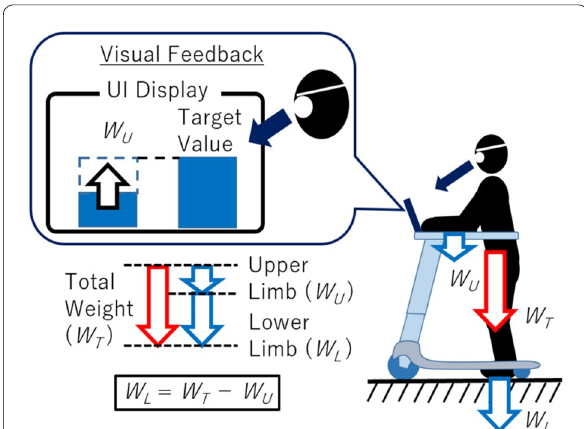
Fig. 3 When W U is applied to the walker, W L is reduced following the relationship between the load applied to each limb and W T , as given in Eq. (1). It is possible to quantitatively adjust the loads measured by the load sensors while looking at the graph and target value on the UI display attached to the